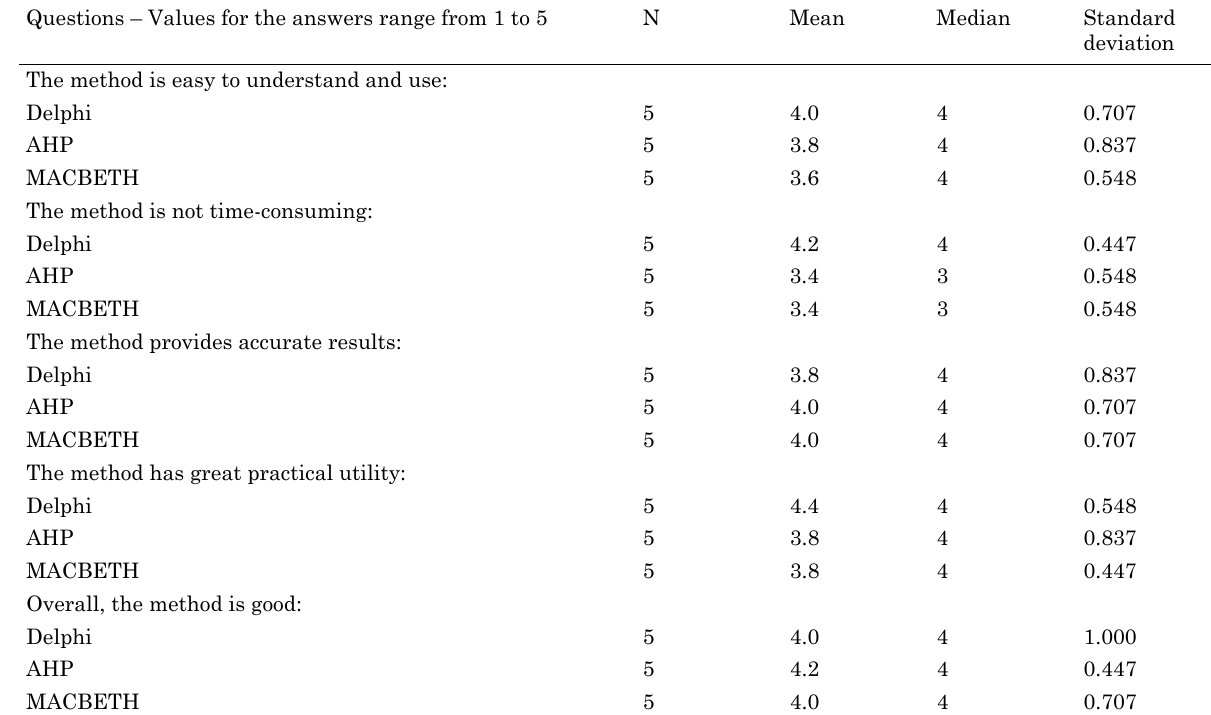
Table 8. Comparison of methods Questions – Values for the answers range from 1 to 5